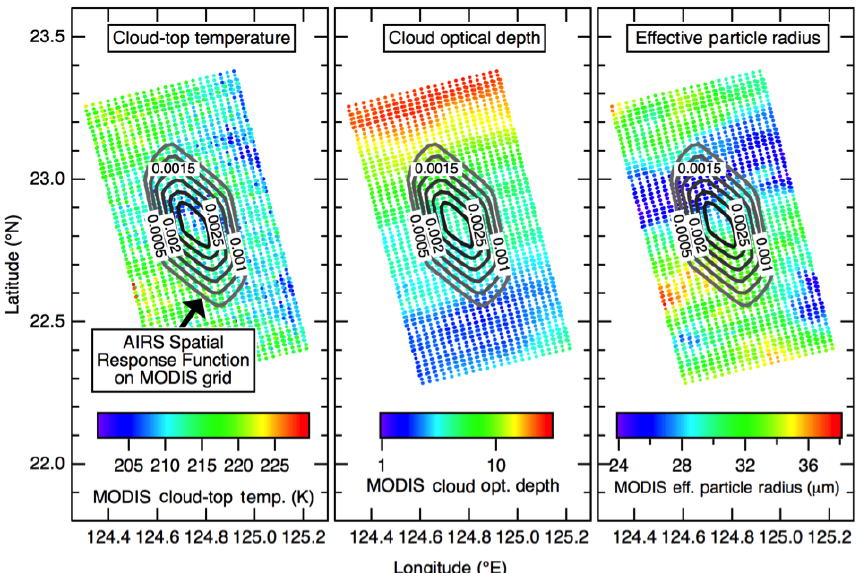
Figure 3. Sample MODIS fields of cloud-top temperature, cloud optical depth and effective particle size overlaid with the AIRS spatial response function (SpatialRF) interpolated to the MODIS grid. Data are daytime observations over ocean from 6 September 2002. For this example, the weighted averages over the AIRS SpatialRF are 211.3K for cloud-top temperature, 4.26 for optical depth and 29.5µm for effective particle